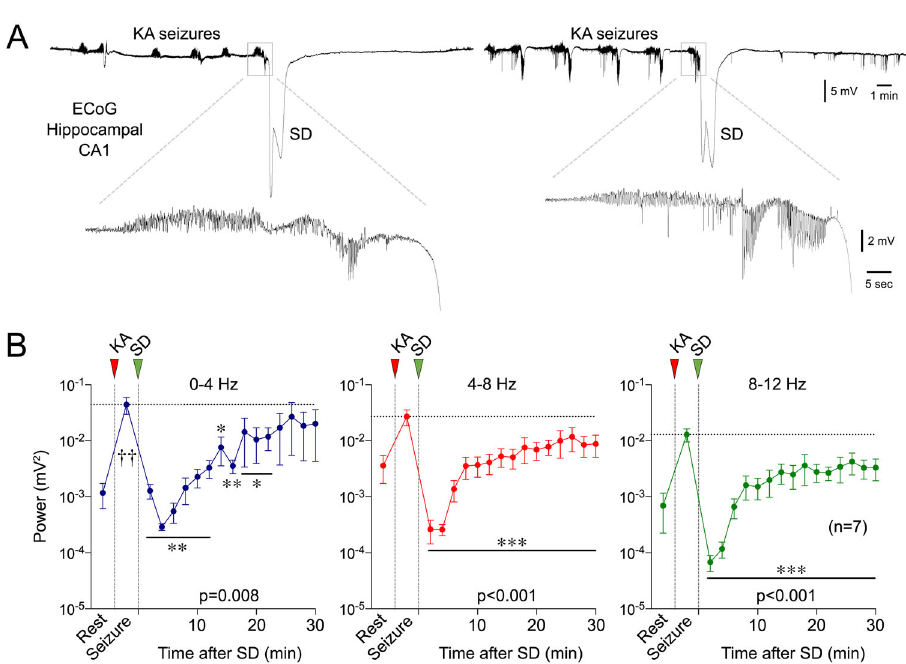
Fig. 10 Spontaneous SDs during systemic kainic acid-induced global seizures terminate the seizures and limit their reemergence. A Representative hippocampal recordings (DC) show seizure characteristics and SD emergence in two animals. B Average ECoG power time course in δ (0 – 4 Hz), θ (4 – 8 Hz), and α (8 – 12 Hz) frequency bands show ECoG power at rest, during the seizure (5 min prior to SD, and every 2 min thereafter. All frequency bands showed a signi fi cant reduction in seizure power for at least 20 min after SD. The sample size is shown on the graph. *-*** p < 0.05 – 0.001 vs. pre-SD seizure power (one-way ANOVA for repeated measures;